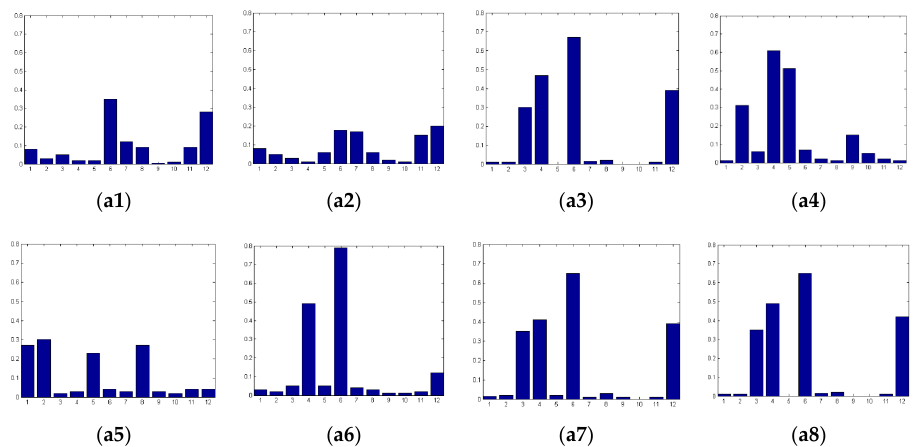
Figure 8. The examples of texture features of pictorial regions in the shearlet domain; ( a1 – a8 ) are the SLBP histograms of pictorial regions contained in the corresponding subgraphs ( a1 – a8 ) of Figure 5. Each subgraph of ( a1 – a8 ) contains two concatenated SLBP histograms.